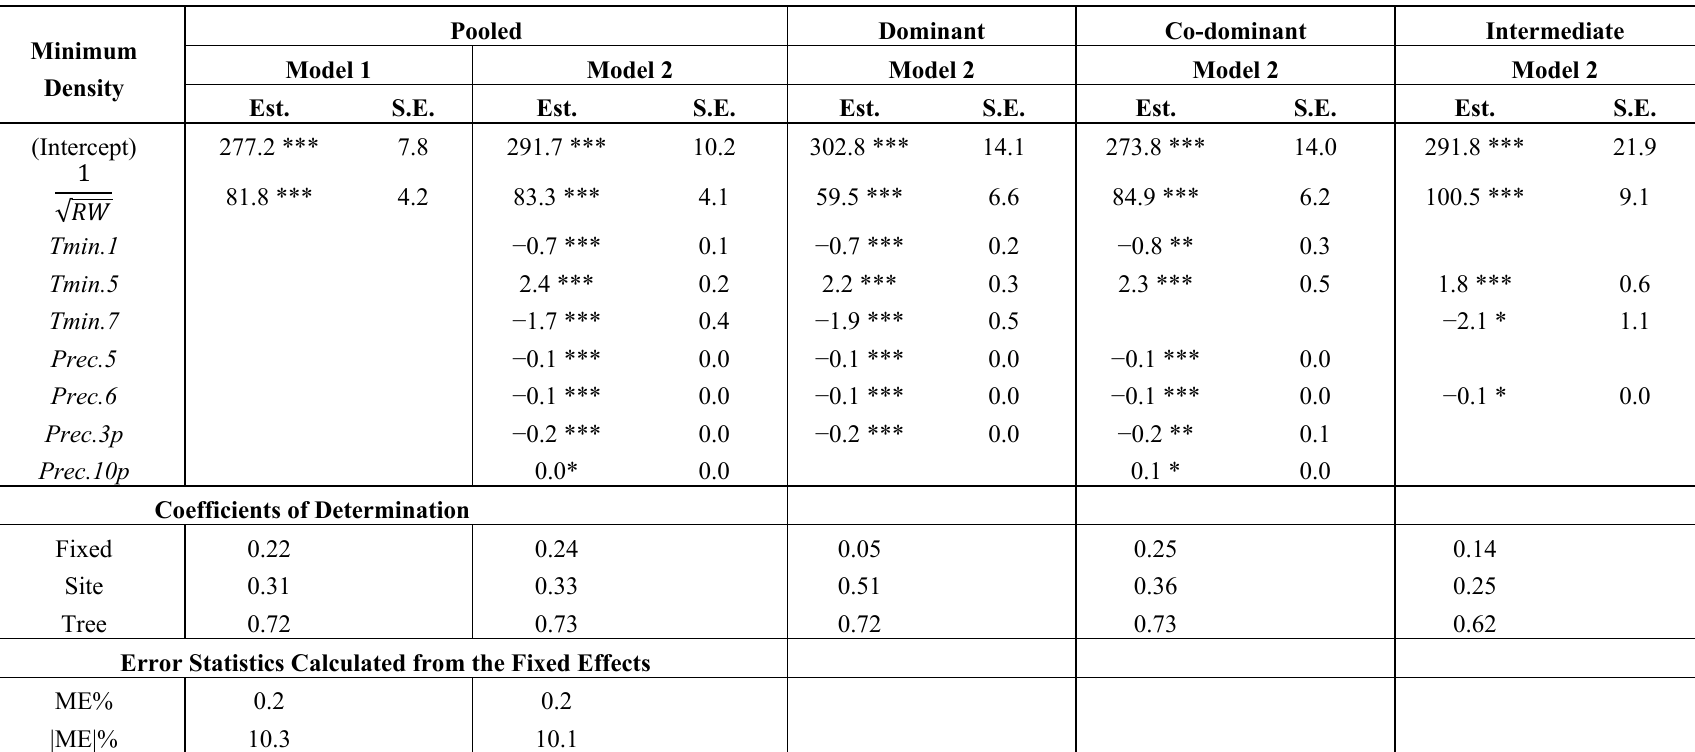
Table 3. Estimated coefficients (Est.) and associated standard error (S.E.) for minimum ring density at different dominance